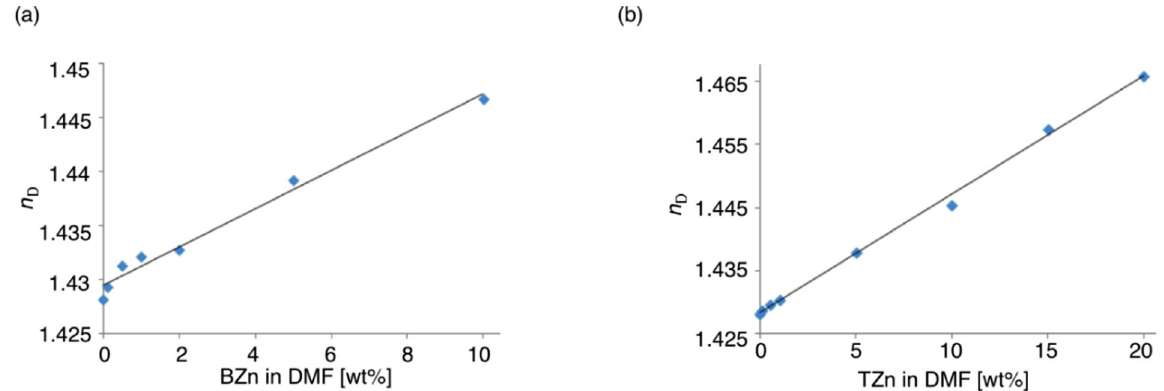
Figure 4. Concentration dependences of n D of DMF solutions of ( a ) BZn; and ( b )